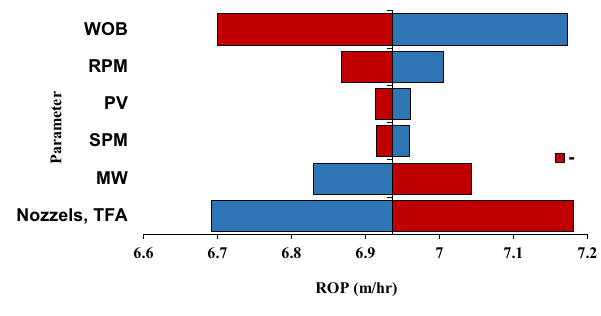
Fig. 31 Tornado chart for ROP